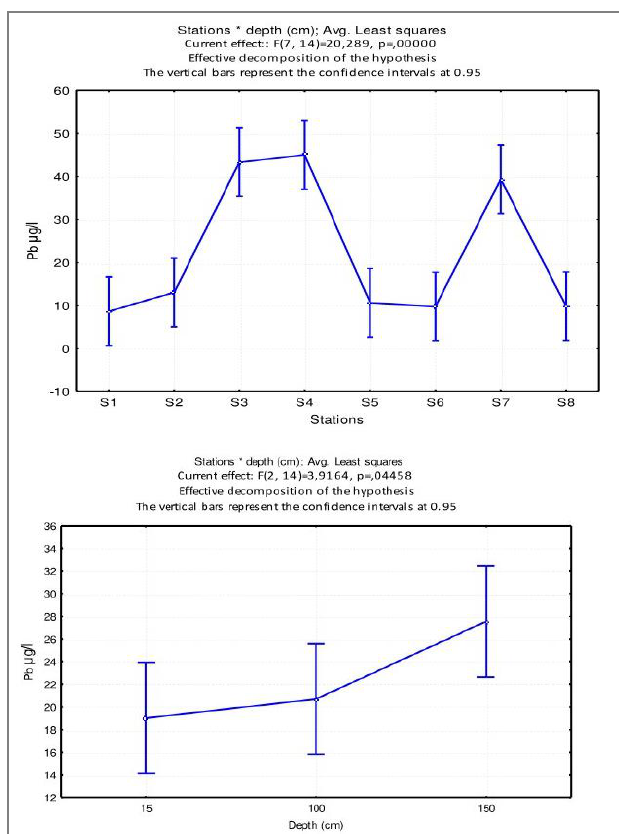
Figure 13. Spatial variation of Pb in μg / l in Lake Reghaia. The concentrations of Cobalt and Ag vary in a similar way, relatively low ( Figures 14,15 ), respectively of the order of 2.1 and 5 μg ∙ L-1.The measured concentrations show the following classifications: Fe> Zn> Cu> and